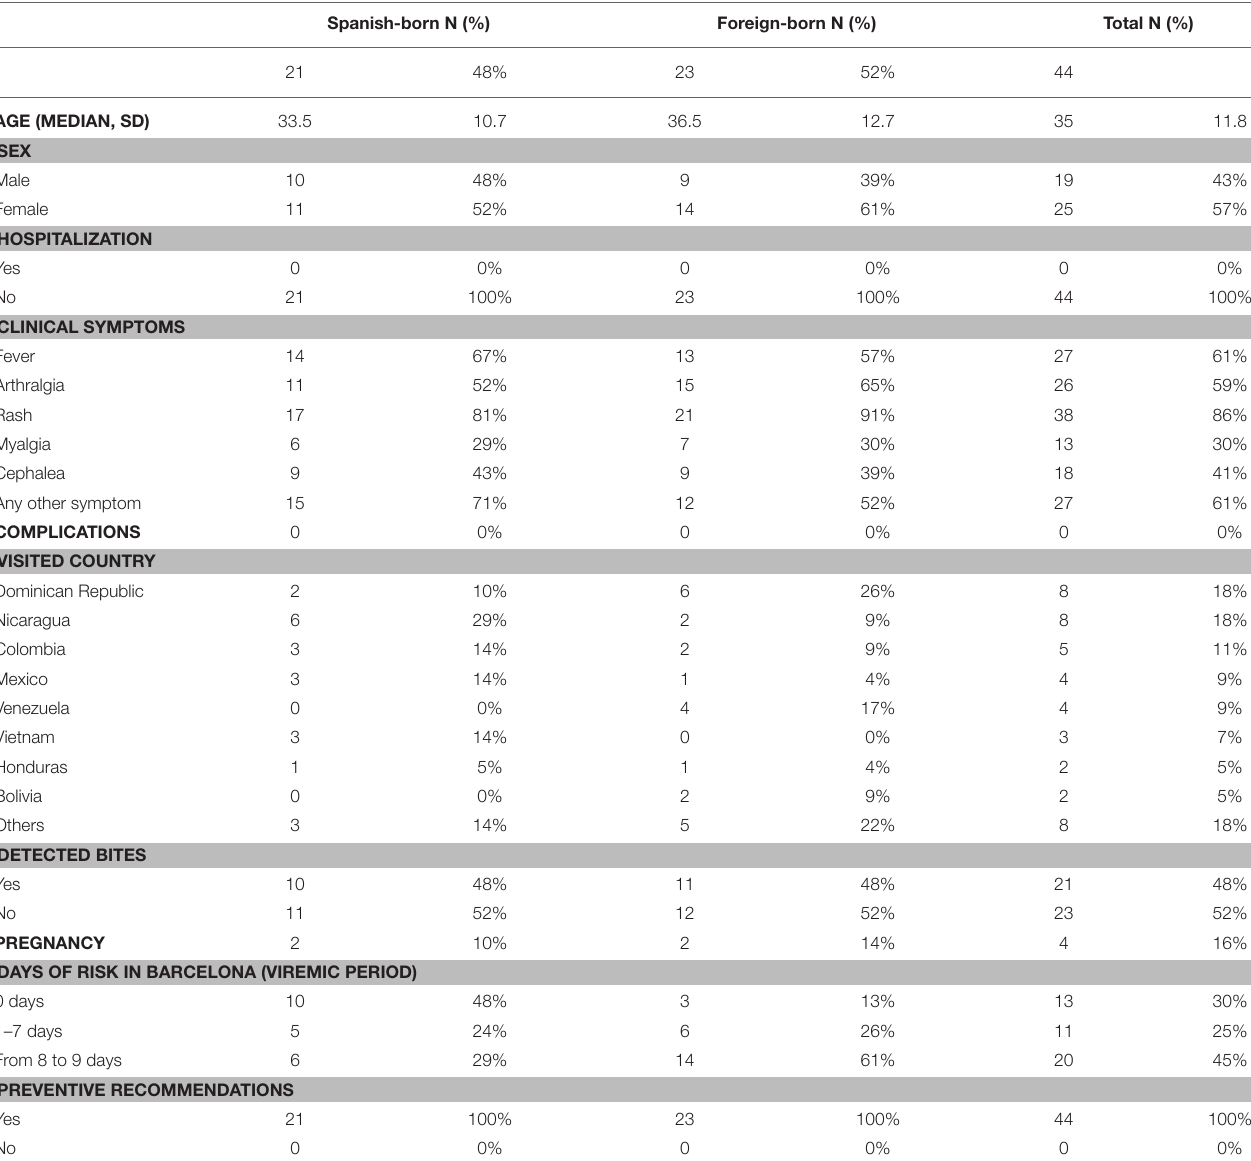
TABLE 1 | Comparison of the descriptive characteristics between Spanish born and foreign born for the 44 confirmed cases of Zika virus infection in the city of Barcelona. January–November 2016. Spanish-born N